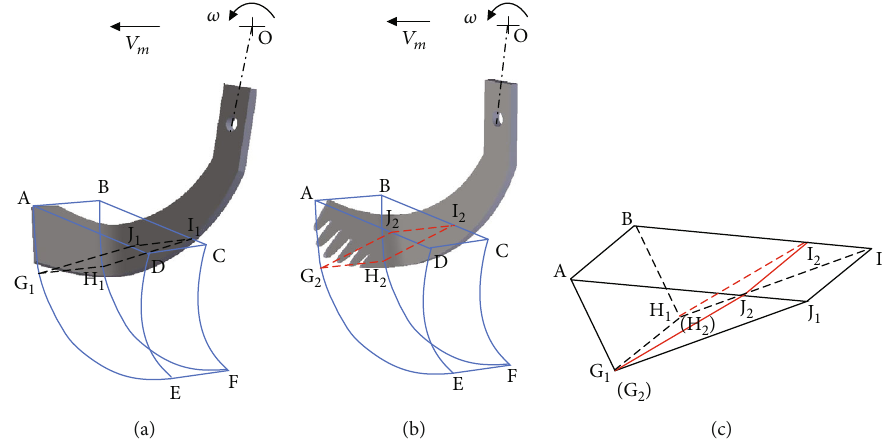
Figure 15: Soil wedge formed in front of the rotary tillage blade: (a) the conventional (CB); (b) the optimal biomimetic (BB-1); (c) the comparison between the CB and the BB-1. Note: ABEF — soil surface cut by the blade; CDEF — previously soil surface cut by the preceding blade; ABI1J1G1H1 — soil wedge formed in front of the CB; ABI2J2G2H2 — soil wedge formed in front of the